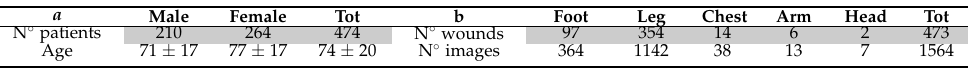
patients, which are split according to sex and age. (b) Description of the images involved in the study. We report the number of images split according to anatomical positions. The same wound could have been acquired at different time points. We report, in the last row, the number of images associated with each anatomical